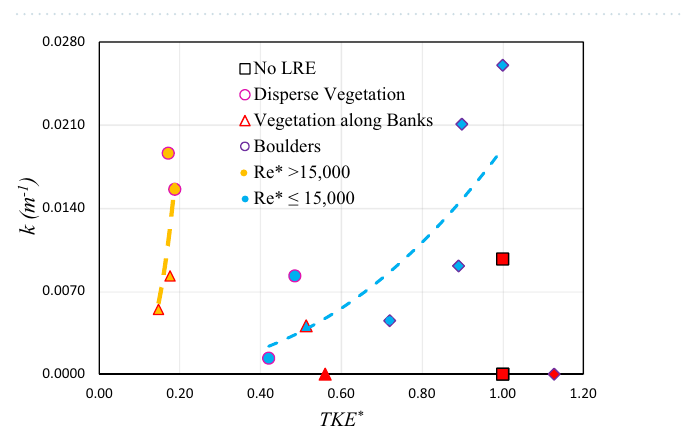
Figure 5. The percentage pass of PS-MPs for different scenarios ( a ) vegetation scenarios and ( b ) boulders scenarios.